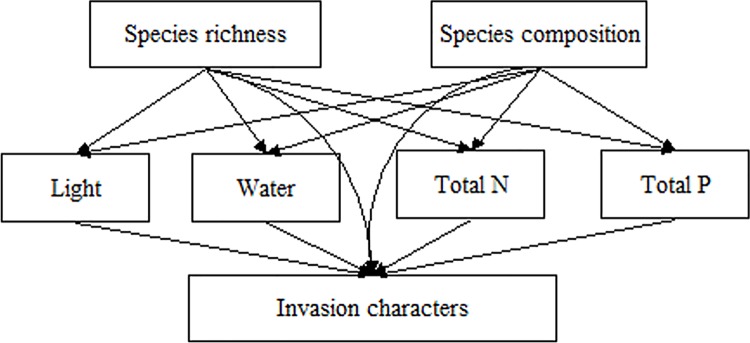
A priori structural equation model representing hypothesized relationships among the species richness, species composition, resources (light, soil water content, total N and total P) and invasion characters (species number, biomass and seedling number of total and exotic invaders).